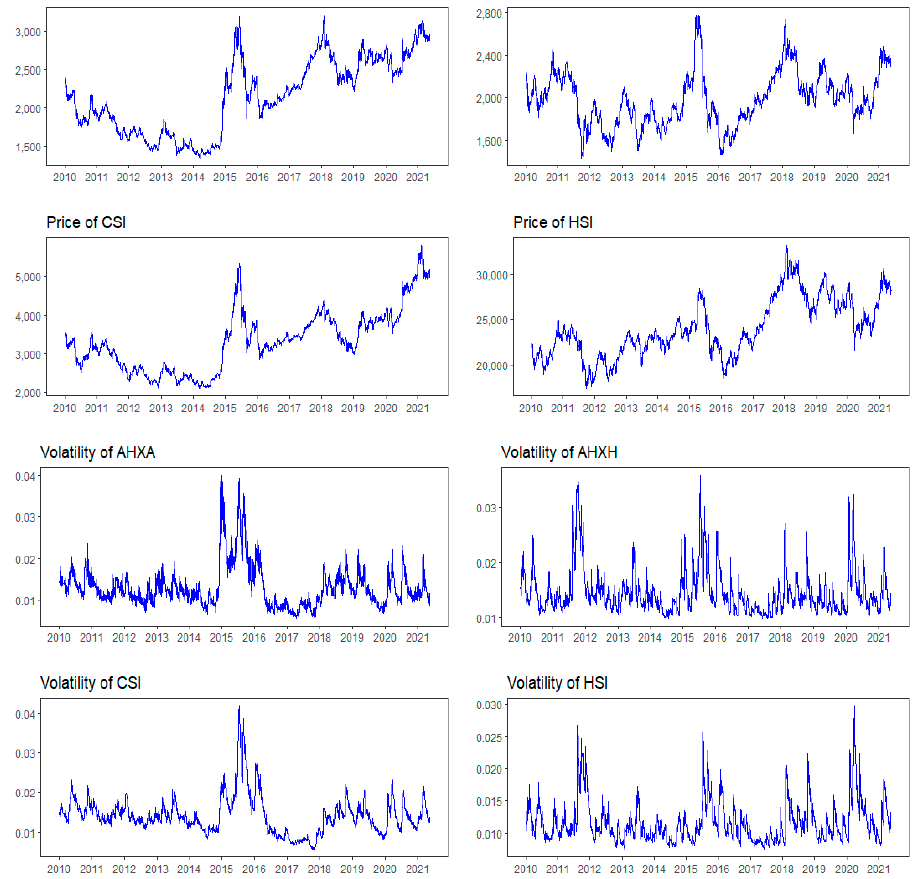
Figure 1. Time-paths of the considered variables.